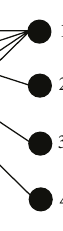
Figure 4: Matching between feature point